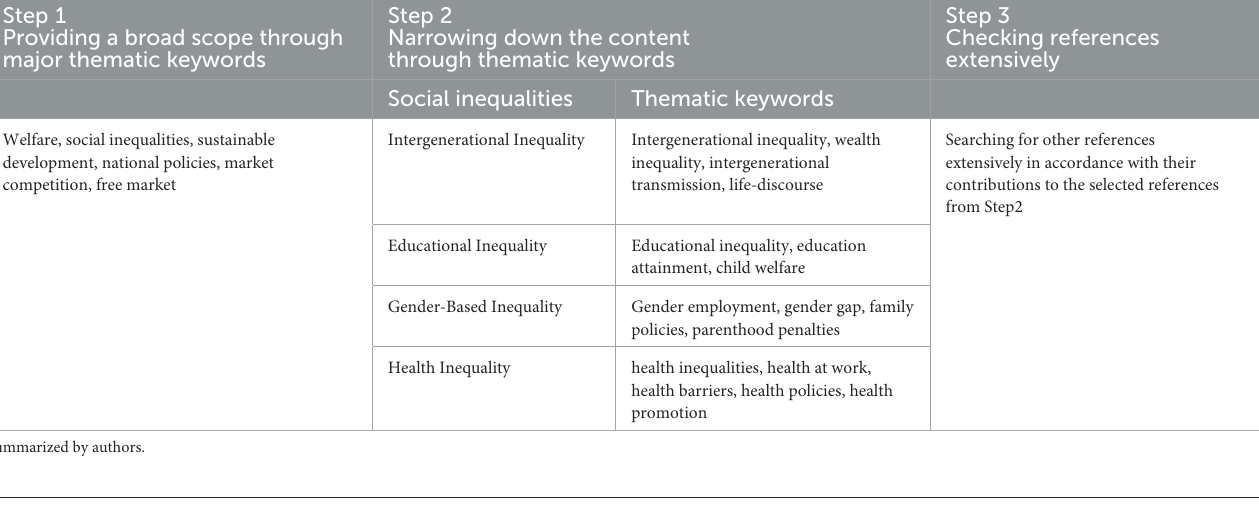
TABLE 1 Data collection procedure.